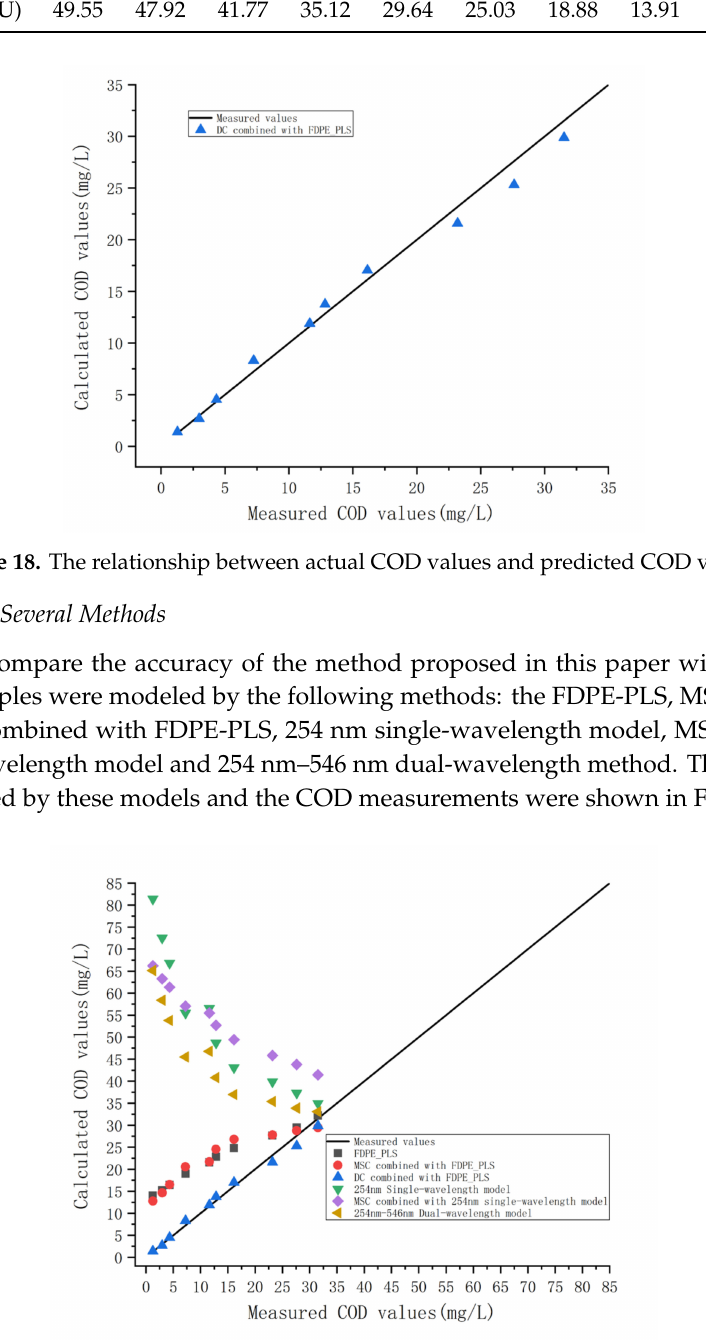
Figure 19. The comparison between di ff erent modeling